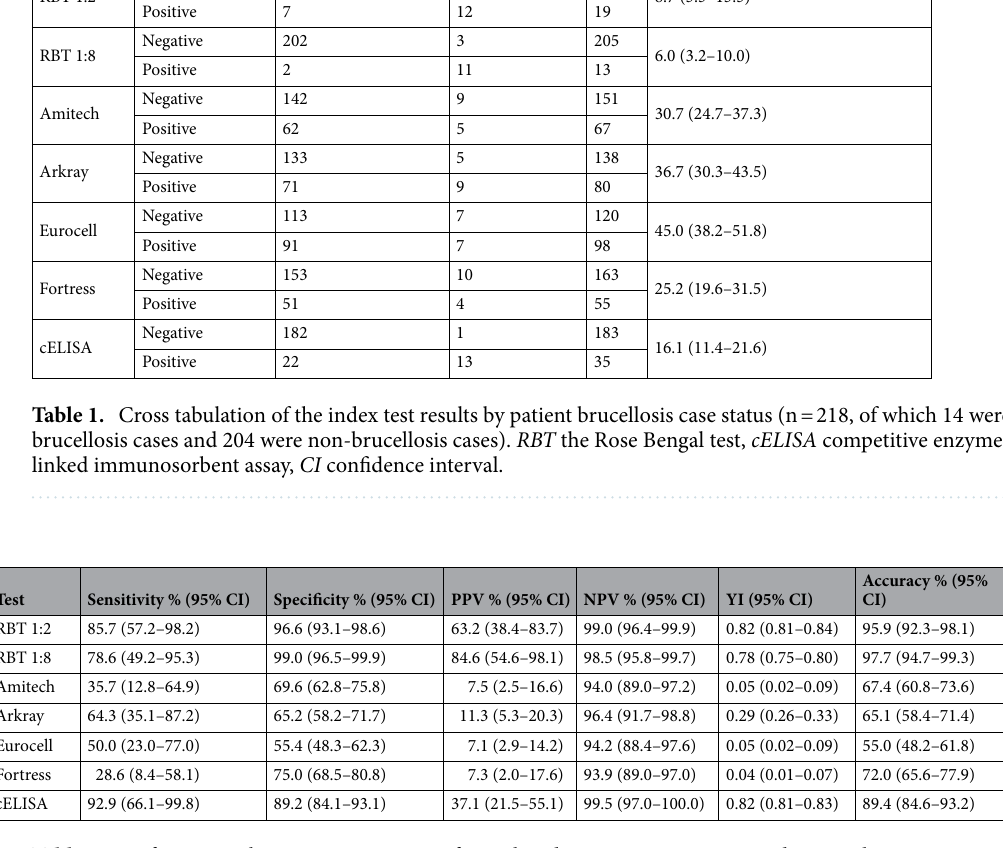
Table 2. Performance characteristic estimates for each index test. PPV positive predictive value, NPV negative predictive value, YI Youden’s index reported to two decimal places, RBT the Rose Bengal test, cELISA competitive enzyme-linked immunosorbent assay, CI confidence